Question: Briefly state, in one sentence, what is plotted here.
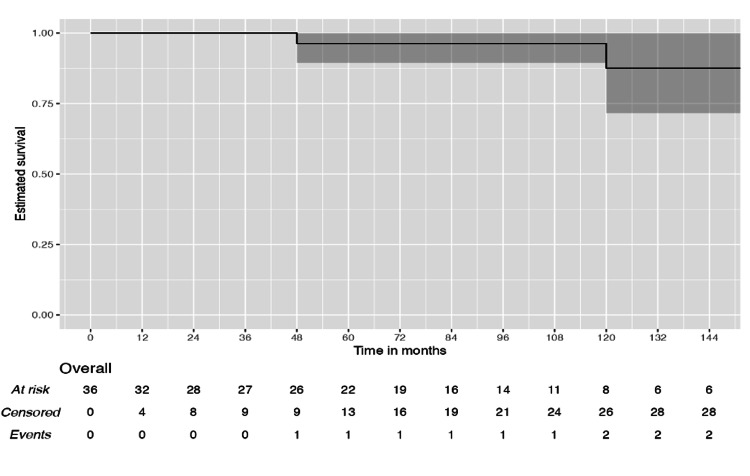
Answer: Kaplan-Meier overall survival curve of living-related kidney donors during follow-up